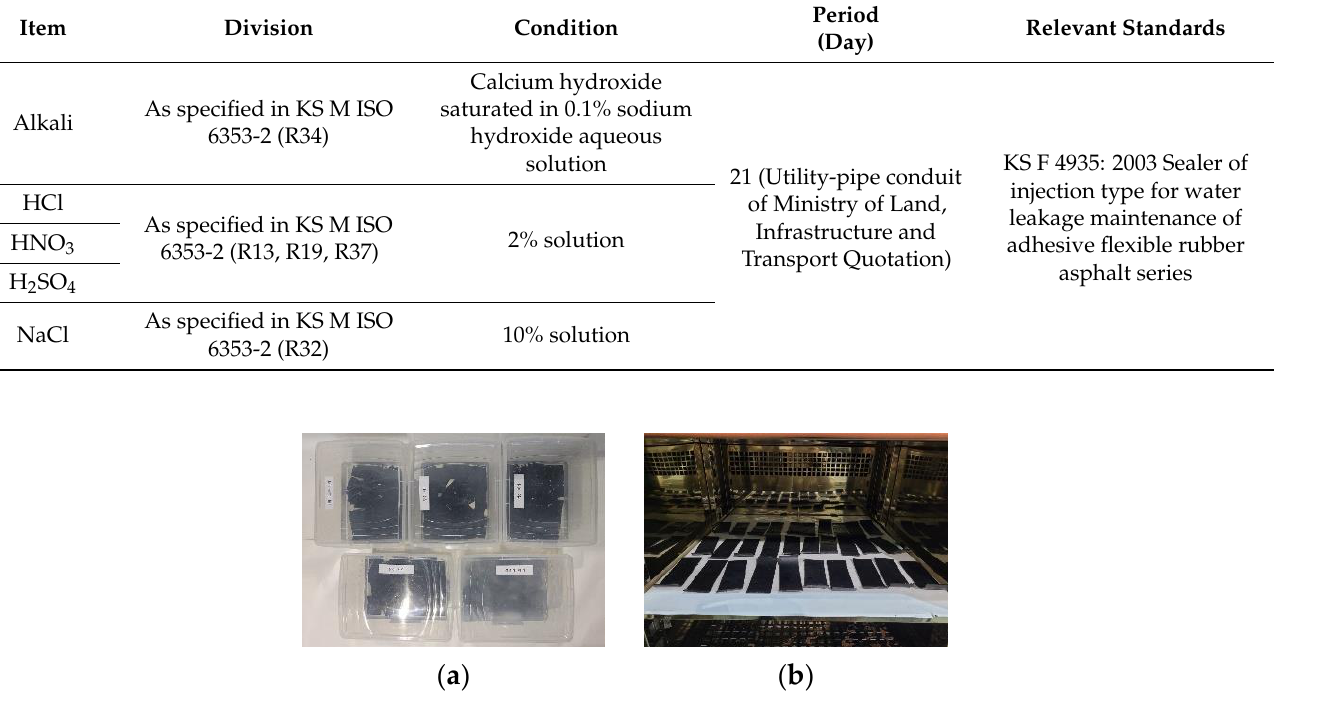
Figure 4. Specimen deterioration treatment status. ( a ) Five types of chemical treatment; ( b ) After washing, dry for 24 h in a constant temperature chamber at 20 ◦